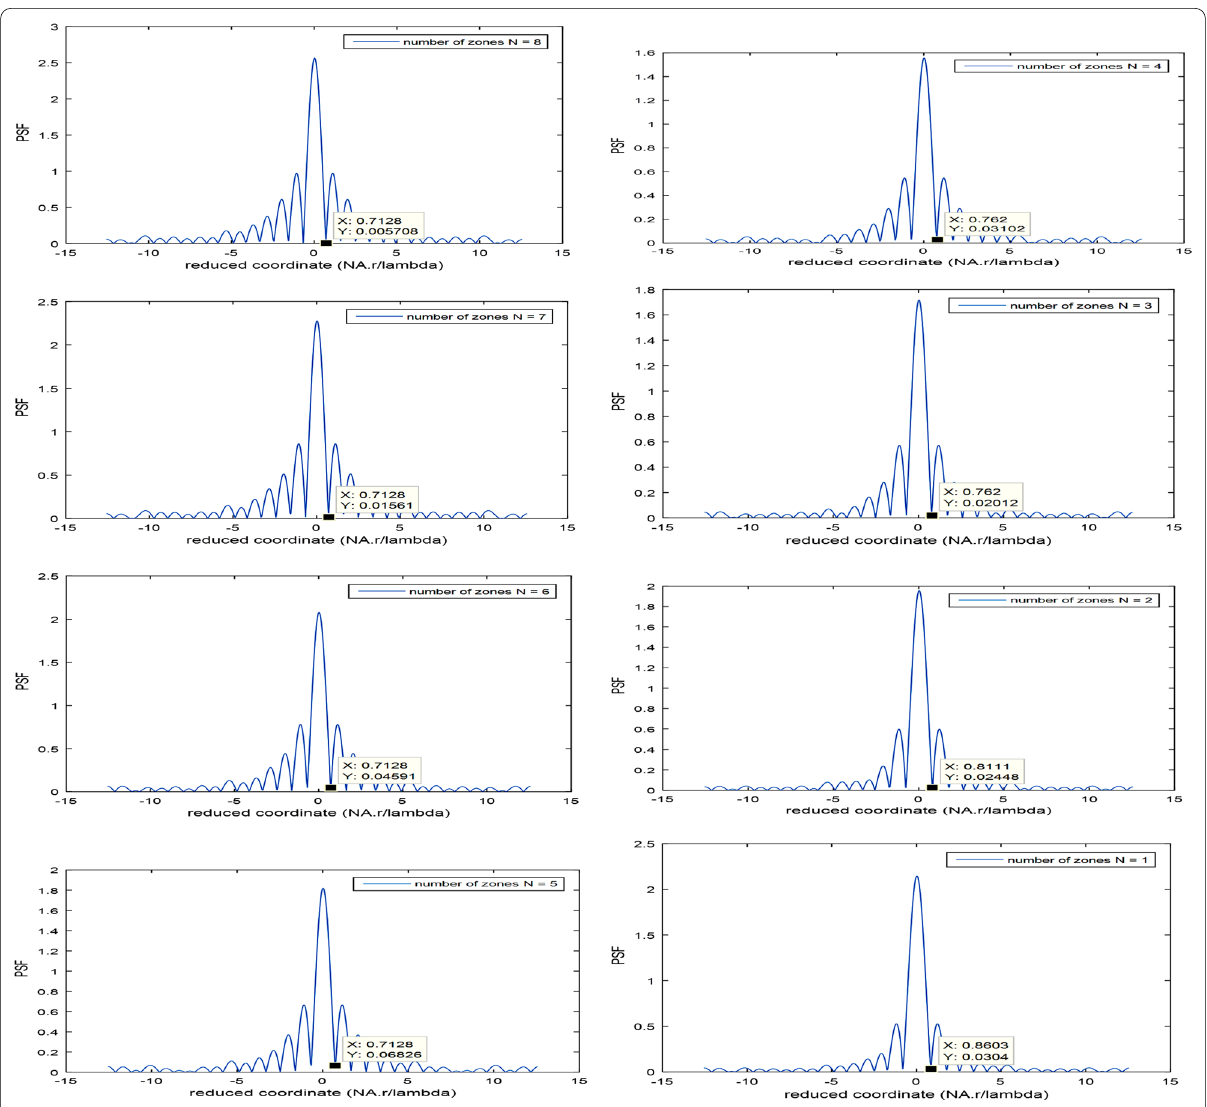
Fig. 5 Influence of the number of zones corresponding to the first model of polynomial aperture upon the PSF. The cut-off spatial value in reduced coordinate is varied from 0.7128 for N up to N 8. In addition, another equal value is shown at 0.762 for N = N 1 at =